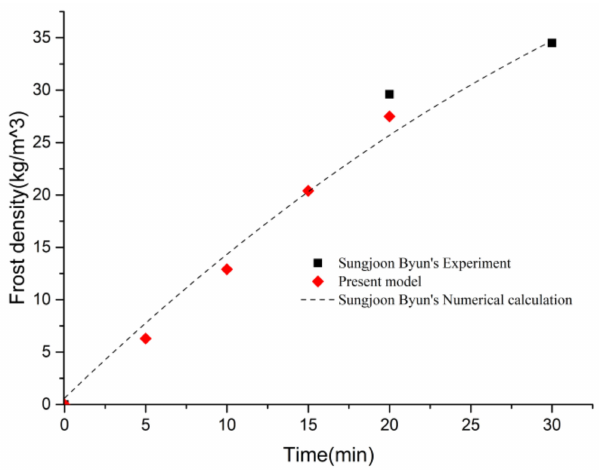
Figure 6. Tube frosting verification.